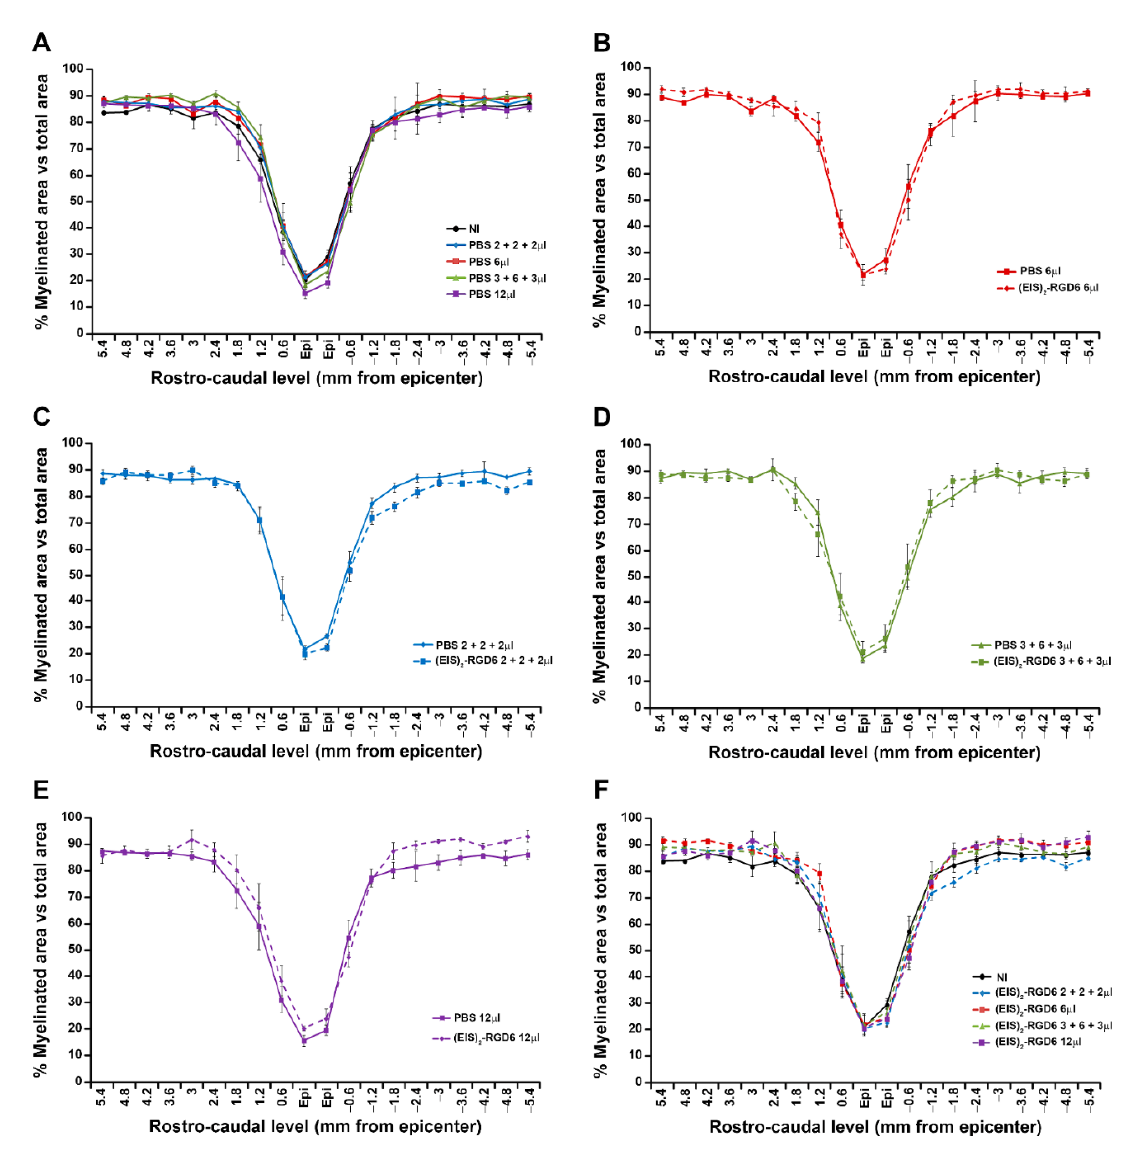
Figure 7. Determination of the injection system: Myelin preservation. Graphs show data obtained